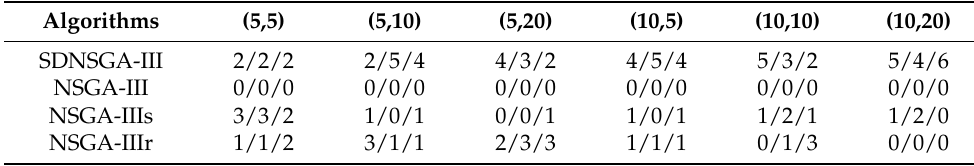
Table 7. The statistical results of six parameters on different